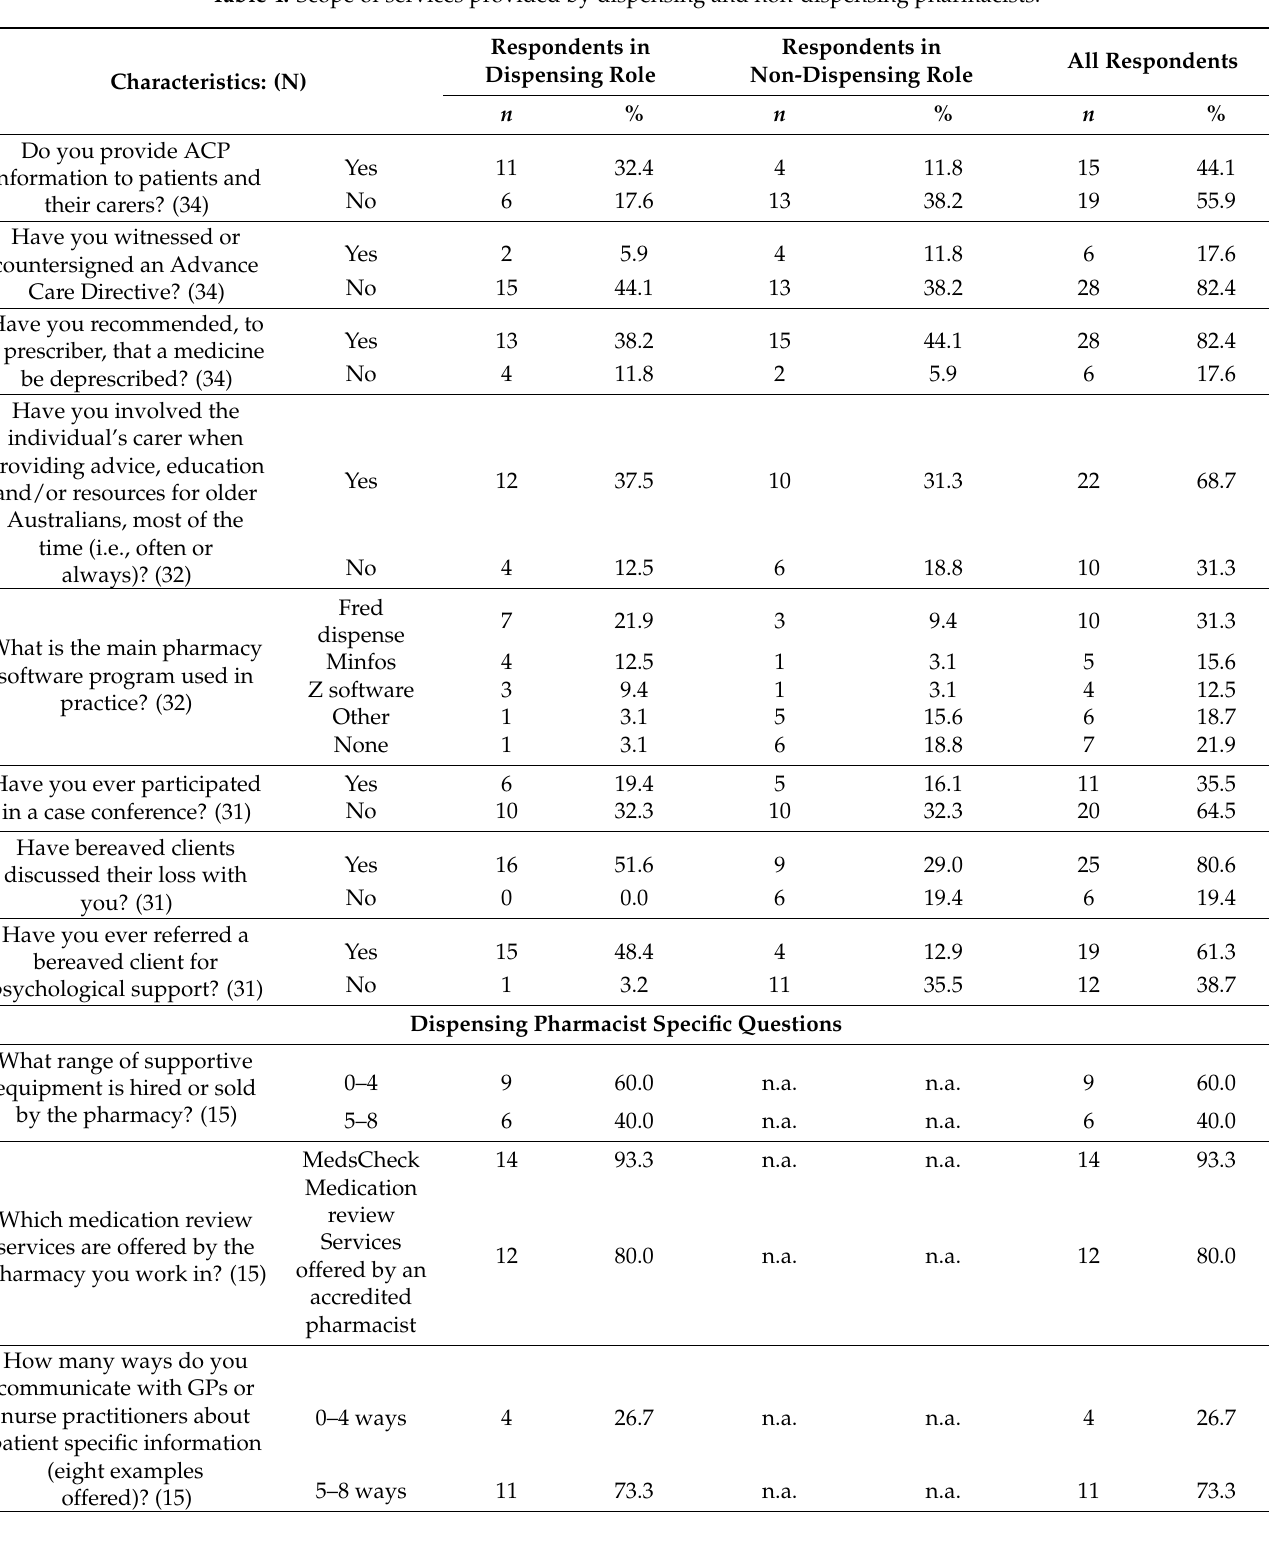
Table 4. Scope of services provided by dispensing and non-dispensing pharmacists.